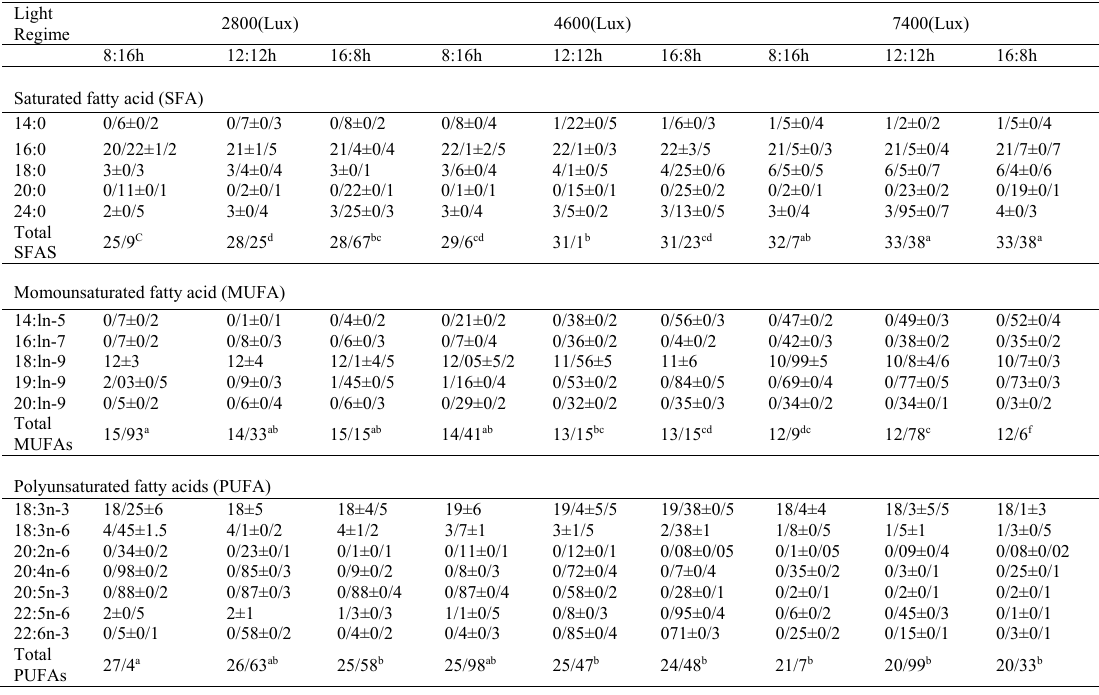
Table 1: Fatty acid composition of Chlorella vulgaris in different light regimes (Richmond et al ., 2004) Light Regime